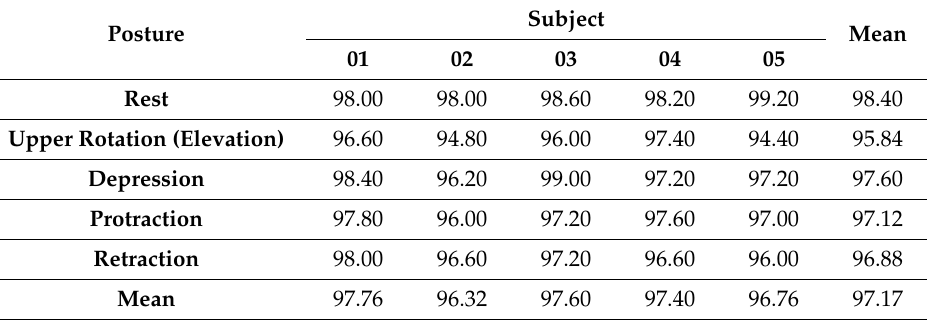
Table 2. Classification accuracy of shoulder postures using the proposed convolutional neural network (CNN) networks (%).